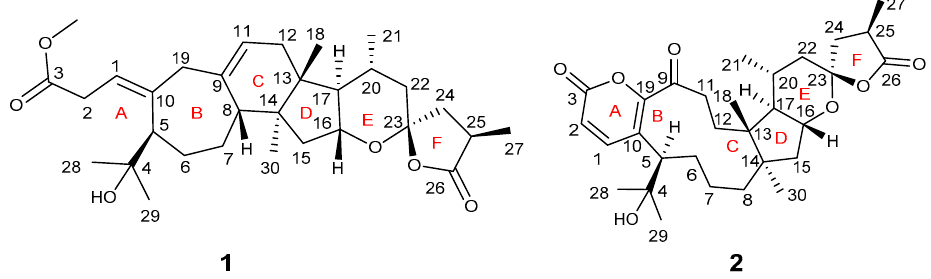
Figure 1. The structures of compound 1 and compound 2 from Codonopsis pilosula.